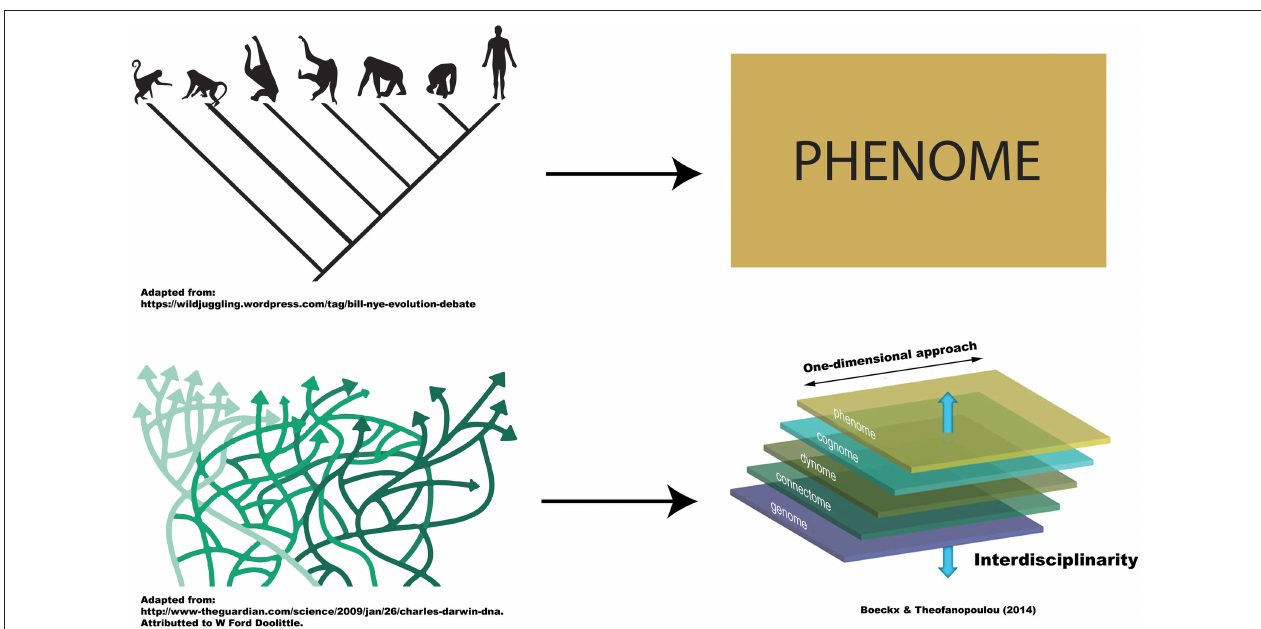
FIGURE 1 | Uni-dimensional vs. Multi-dimensional approaches to (cognitive) phylogenies. The figure is meant to represent the fact that traditional, tree-like cognitive phylogenies can only be entertained if we adopt uni-dimensional approaches. As soon as we integrate information across levels of description (multi-dimensional approaches), the topology of cognitive phylogenies changes dramatically, to the point of being unhelpful to depict